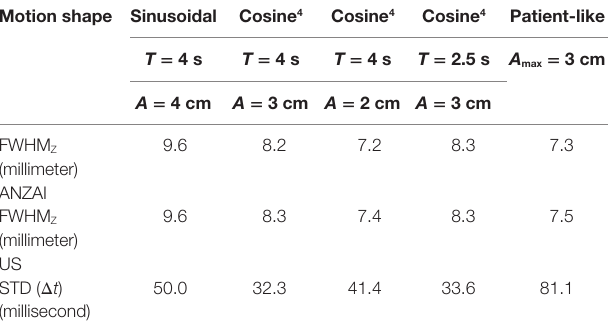
TaBle 3 | geometric distortion caused by the Us transducer being within the lines of response of the PeT scanner. Middle ( Δ x , Δ y , Δ z ) Bottom right ( Δ x , Δ y , Δ z ) (millimeter) (millimeter)